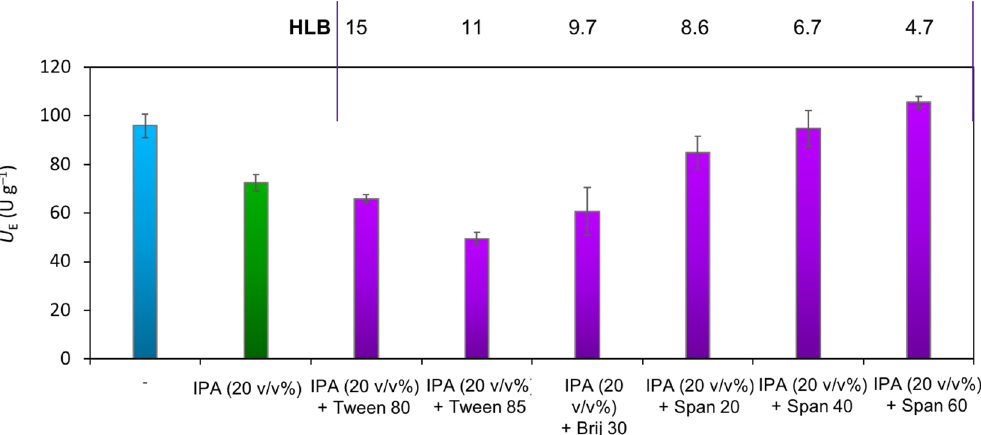
Figure 5. The effect of the emulsifiers (10 mM) with different HLB values on the specific enzyme activity ( U E ) of native Pc PAL in ammonia elimination from L -phenylalanine. Every measurement was made in triplicate, the difference between native enzyme (colored with blue) and samples with IPA (colored with green) and emulsifier (colored with purple) is significant ( p < 0.005) in all cases except samples with IPA (20 v/v%) + Span 40 and IPA (20 v/v%) + Span 60.